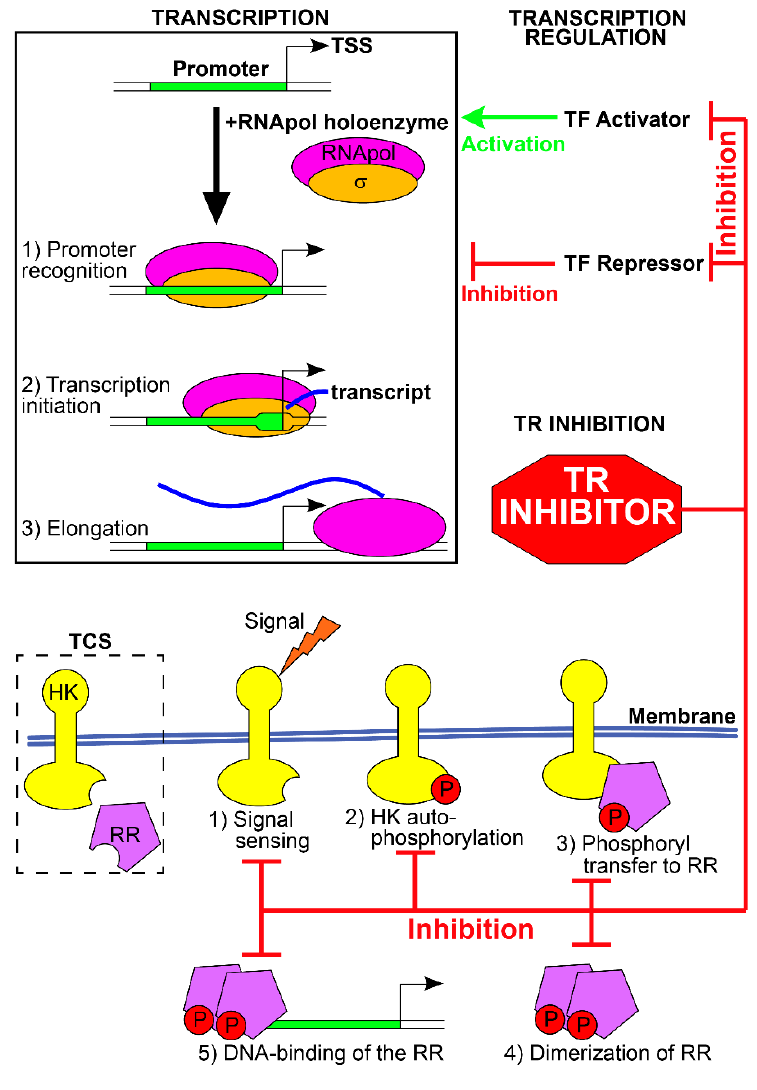
Figure 1. Transcription regulation and TRs as new antibacterial targets. Transcription regulation concerns the key events leading to transcription: promoter recognition by RNApol, core promoter melting and transcription initiation, and elongation (top left box). TRs are activators or repressors, and positively (green arrow) or negatively (red hammerhead) modulate these events, causing gene expression variations. Compounds targeting the TFs and inhibiting their function interfere with the expression of the TR regulon. TCSs typically consist of an HK and a RR (schematized in the broken-line box). Upon signal sensing, HK undergoes autophosphorylation, the phosphate group is transferred to the RR, which dimerizes and binds the DNA to regulate transcription (steps 1–5). Compounds targeting TCSs can inhibit the various stages of this process.